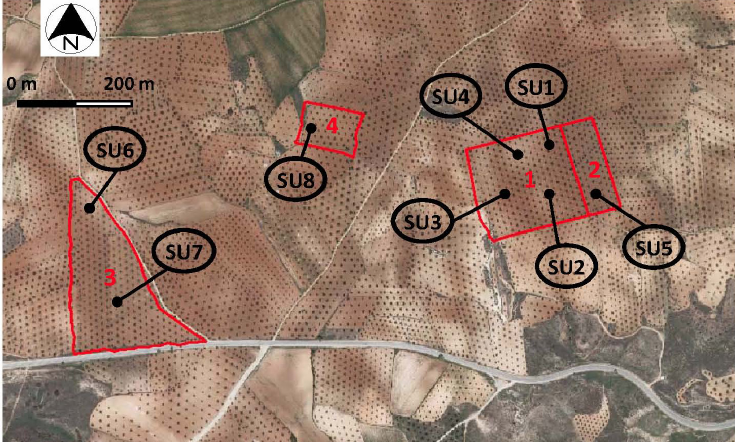
Figure 2. Location of olive grove study areas and corresponding sampling units